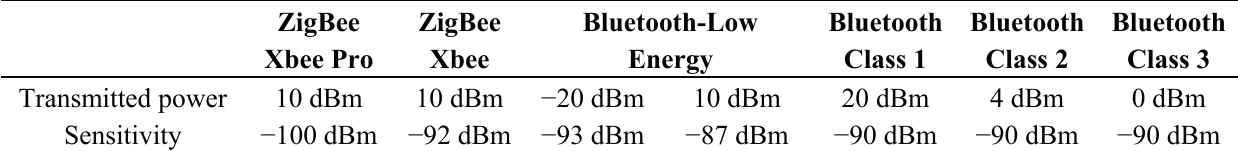
Table 3. Parameters for the different considered wireless communication systems.